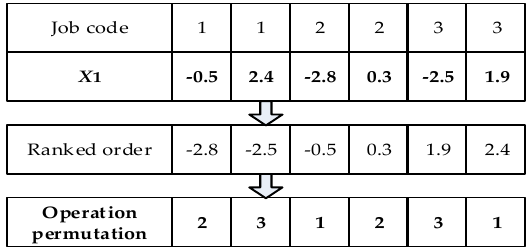
Figure 4. The conversion process from individual position vector to operation permutation.